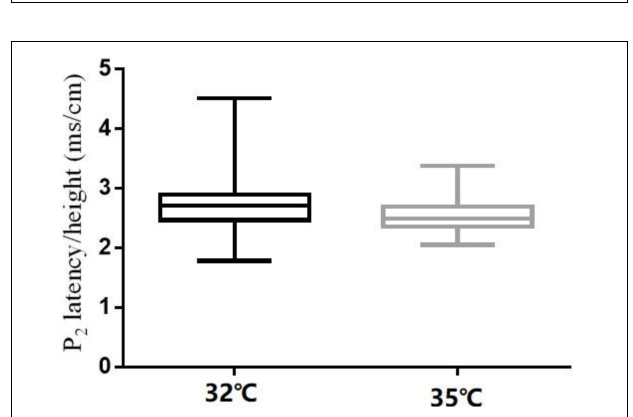
FIGURE 5 | P 2 latency/height at the right forearm for different baseline temperatures (32 and 35 ◦ C).